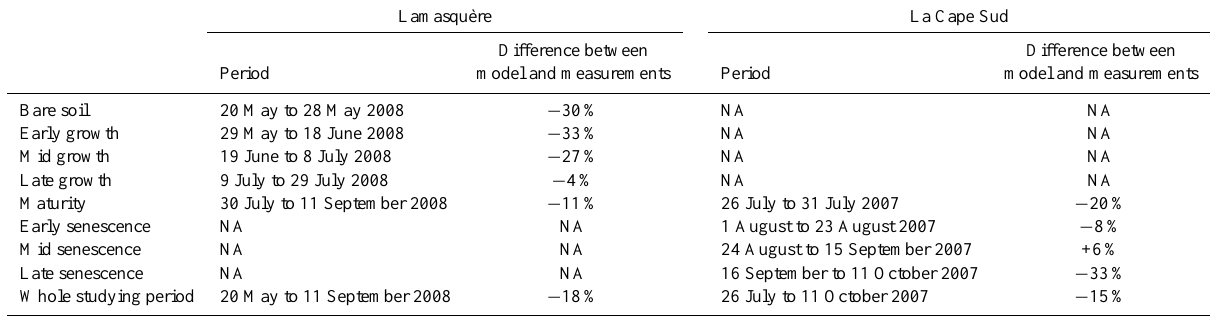
Table 3. Mean relative difference between modelled and measured ozone fluxes over different phenological stages for La Cape Sud and Lamasqu`ere sites. Negative values indicate model underestimation and positive values indicate model overestimation. Lamasqu`ere La Cape Sud Difference between Bare